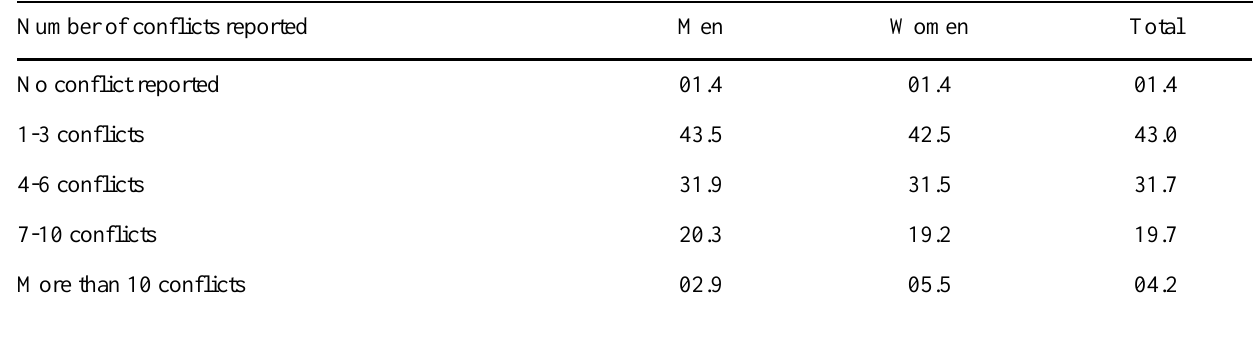
Table 2. Percentage distributions of farmers by number of natural resources management conflicts reported